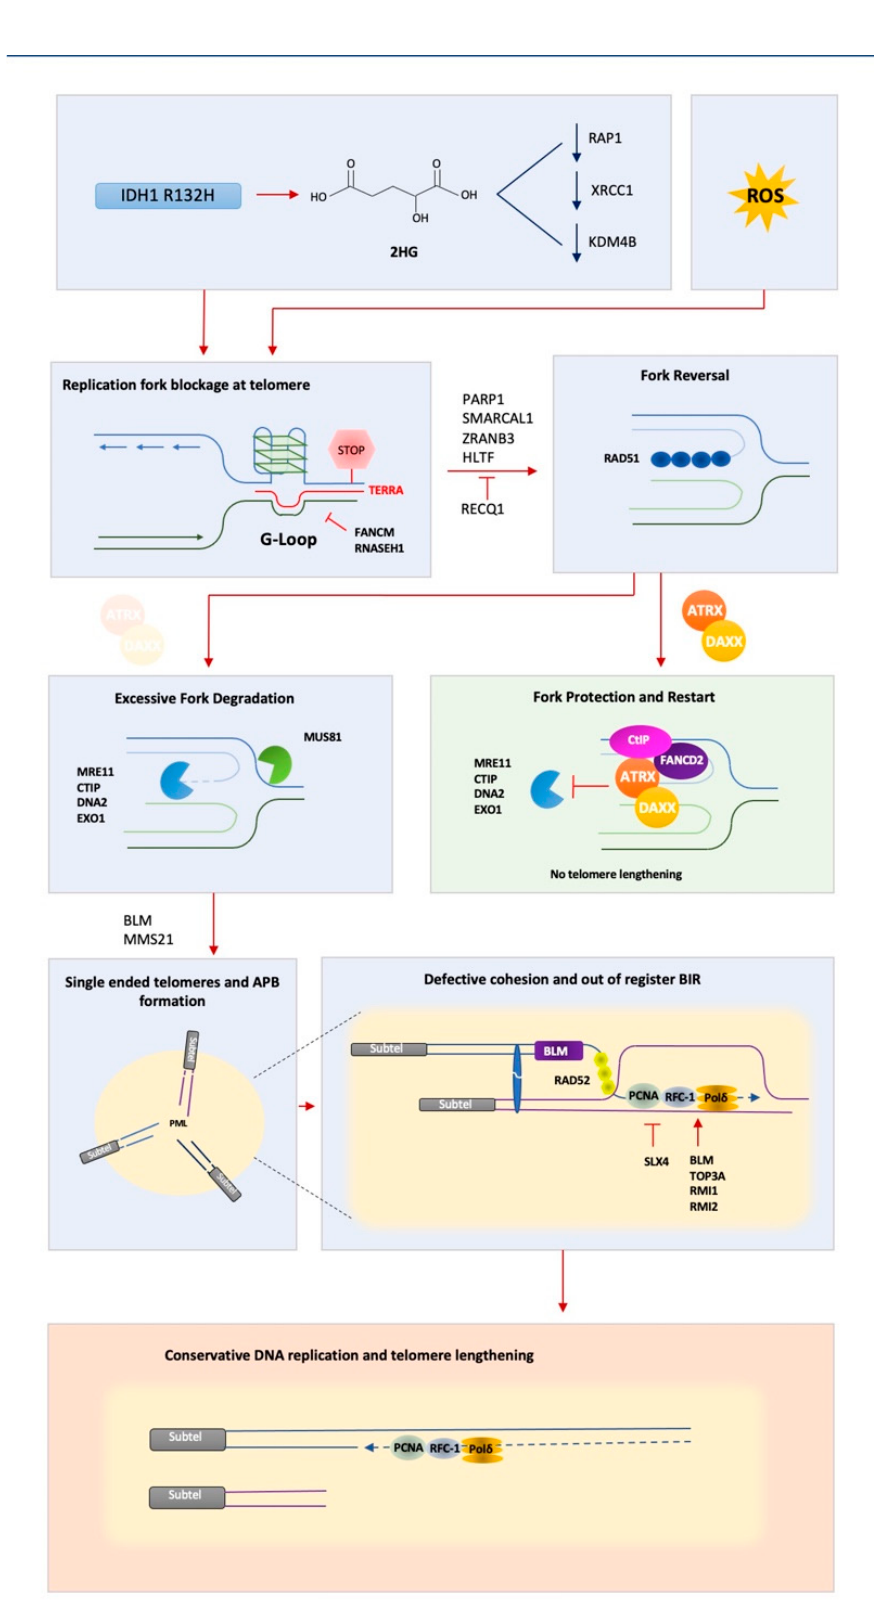
Figure 1. Proposed model for activation of the ALT pathway. Mutation of IDH1 R132H leads to accumulation of 2-hydroxyglutarate, which leads to inhibition of multiple enzymes with functions in both DNA and histone methylation. This has been linked to decreases in expression of XRCC1 and RAP1. Loss of XRCC1 prevents formation of telomeric fusions in ALT cancer cells, whereas loss